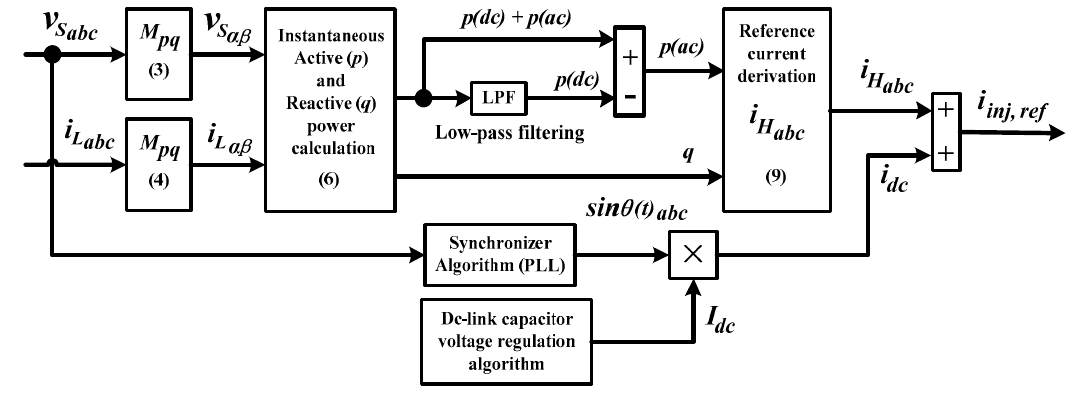
Figure 2. Control structure of reference current generation algorithm based on the existing pq theory.